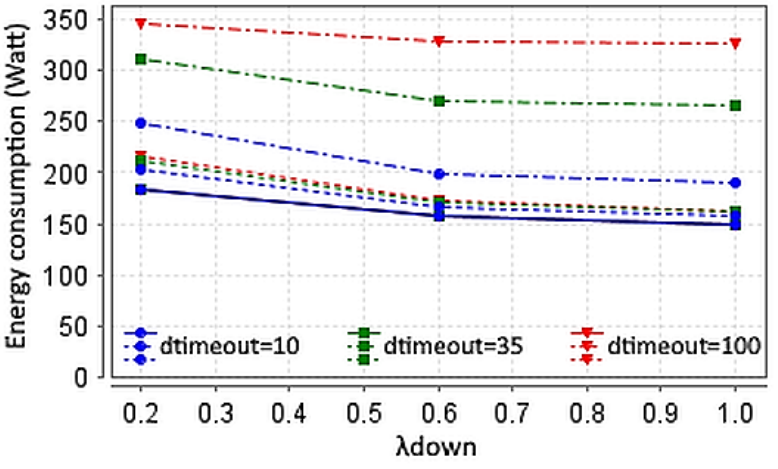
Figure 11. Energy consumption consequences for different d timeout and different r fk values. r fk = 0 (solid line), r fk = 0.5 (dotted line), r fk = 1 (dashed line). In Figure 11, the blue, green, and red curves represent the different d timeout values, i.e., 10 (blue), 35 (green), and 100 (red), which denote the time-out interval period until time-out activation. In this figure, the expected energy consumption is plotted for different values of λ down , keeping the λ up = 0.6. The solid line represents a model where the attacker is not present ( r fk = 0), while the dashed line refers to a model where the attacker intercepts all sleep requests sent from the OLT ( r fk = 1) and the dotted line a model where half of the sleep requests are intercepted ( r fk =